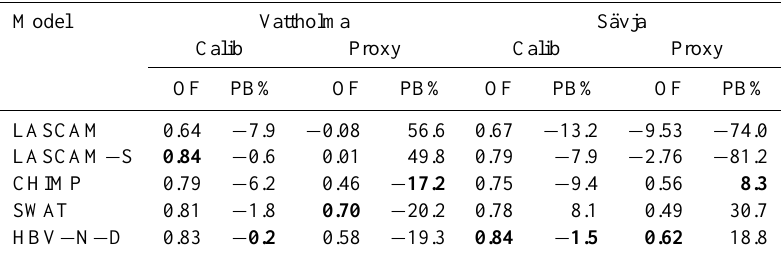
Table 2. Overview of the applied merging schemes for ensemble generation. Merging scheme Description Abbr. Mean Daily mean of the predictions ME Weighted mean Daily weighted mean of the predictions with weights set as WM the value of the criterion OF Median Daily median value of the prediction MD Un-constrained Observations are used as dependent variables while UR multiple linear predictions are used as independent ones and are assigned regression different weighting coefficients Constrained multiple Same as above with an interception constrained through CR linear regression the origin